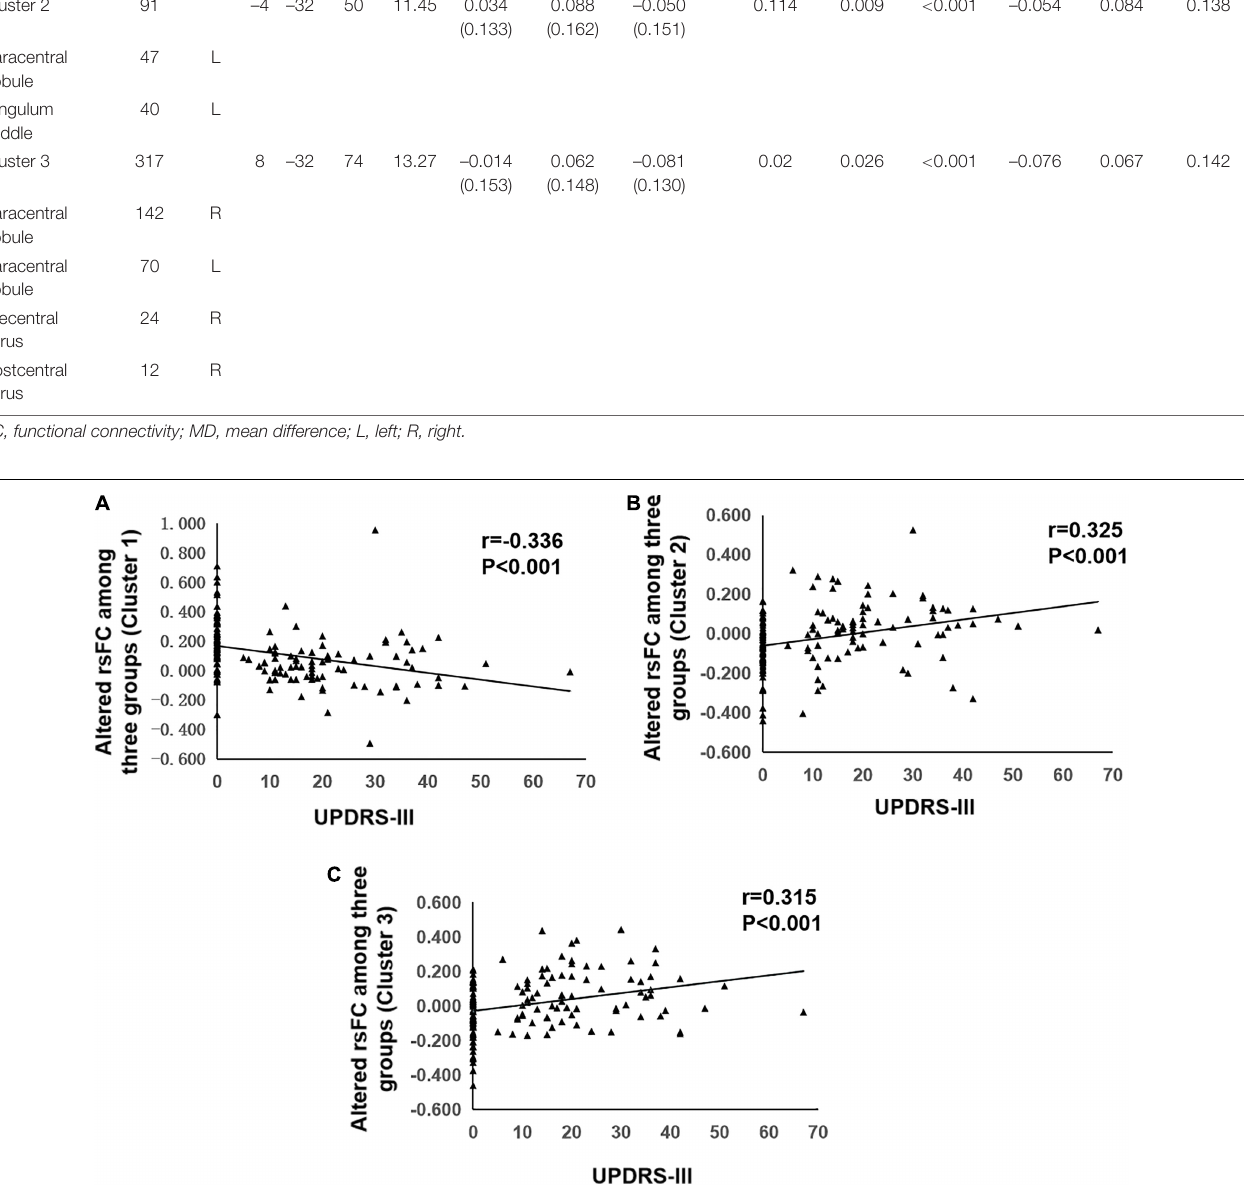
Frontiers in Aging Neuroscience |